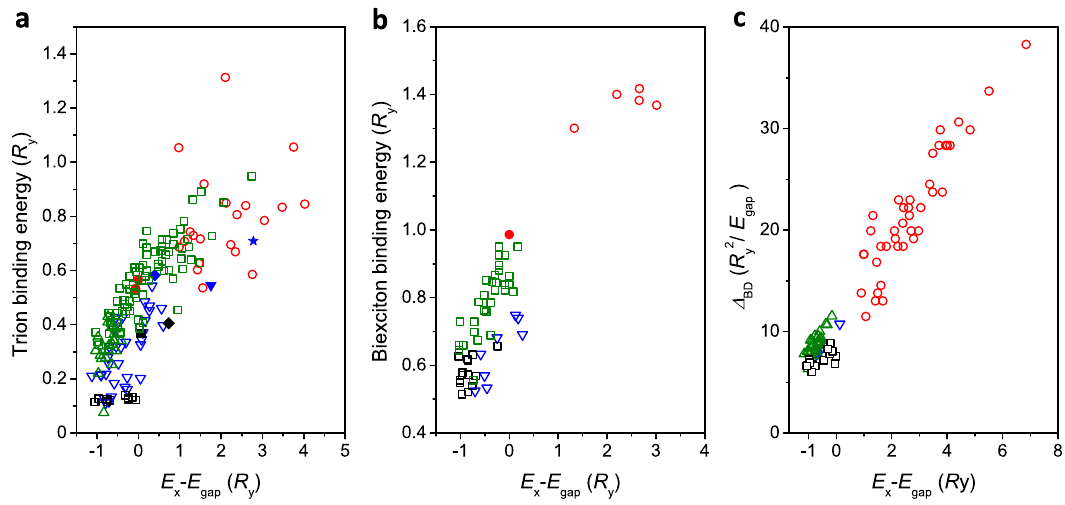
perovskites, the low-temperature bandgaps and bulk exciton binding energies taken for the normalization are deduced from refs. 43,62,63 (See Supplementary Table 1): E gap =2.342eV and R y =33meV for CsPbBr 3 , E gap =1.723eV and R y =15 meV for CsPbI 3 , E gap =2.233eV and R y =24meV for FAPbBr 3 , E gap =2.513eV and R y =42meV for CsPb(Cl x Br 1-x ) 3 with x=0.24. This value of x was adjusted using empirical interpolations of the bandgaps of bulk CsPbCl 3 and CsPbBr 3